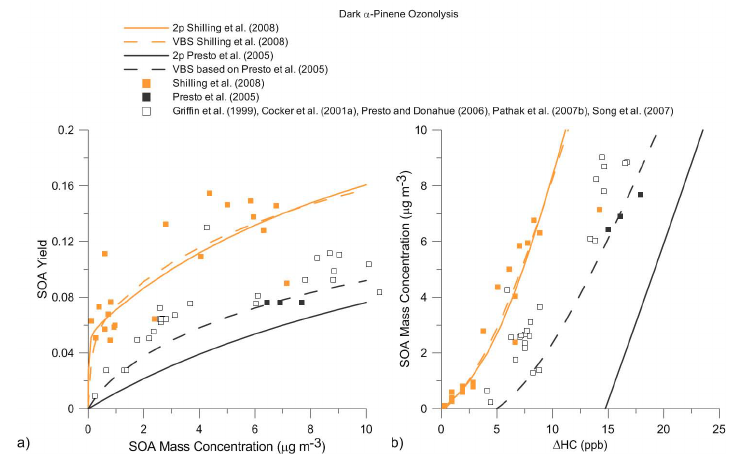
Fig. 1. Comparison of 2p (solid lines) and VBS (dashed lines) parameterizations for dark α -pinene ozonolysis chamber experiments, as influenced by the range in SOA mass concentration and number of data points at low SOA mass concentration. (a) SOA yield vs. SOA mass concentration; (b) SOA mass concentration vs. level of reacted hydrocarbon ( 1